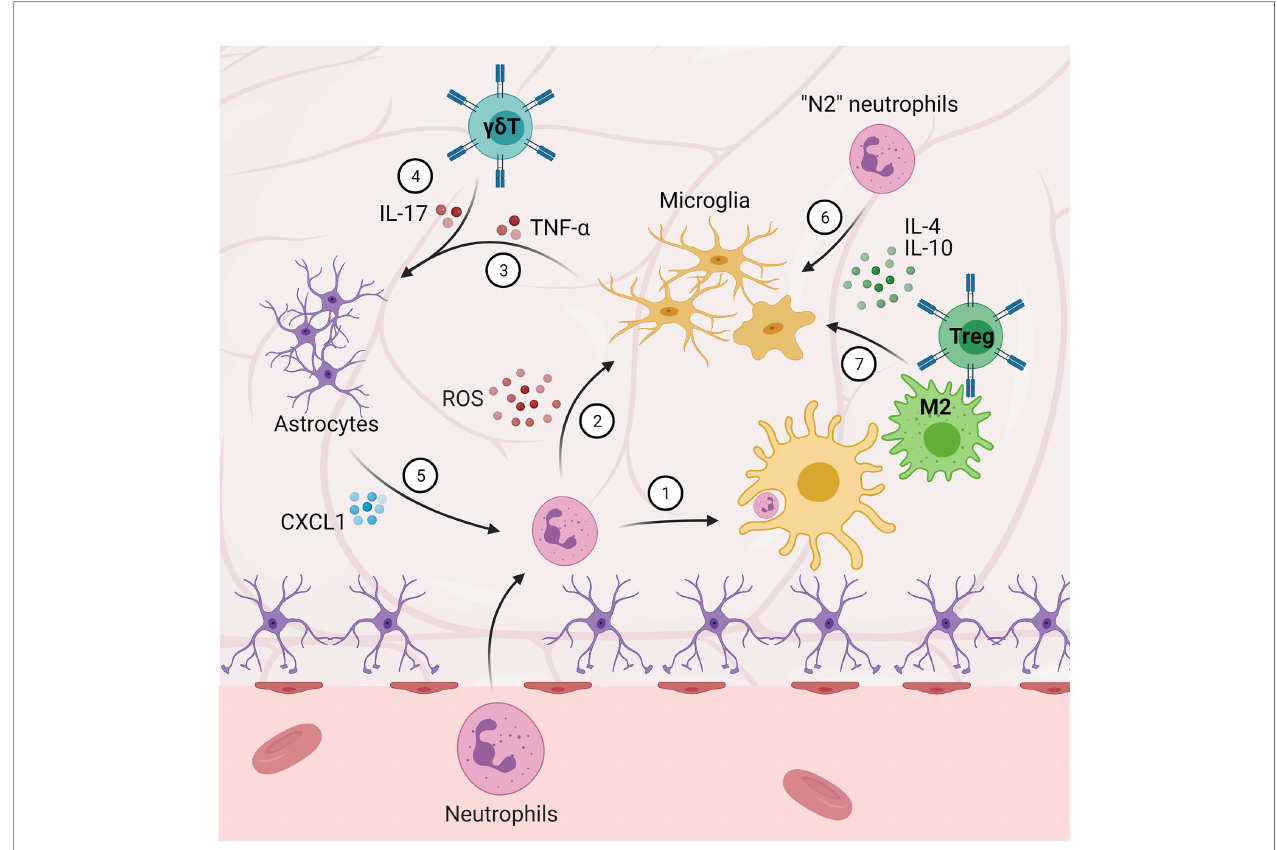
FIGURE 2 | Central-peripheral immune crosstalk in stroke and traumatic brain injury. (1) Microglia phagocytize in fi ltrating neutrophils. (2) Neutrophils that are not phagocytized secrete ROS and proteinases, amplifying M1 microglial activation. (3-5) Microglia-secreted TNF- a and gd T cell-secreted IL-17 induce astrocytic expression of CXCL1, which further contributes to neutrophil-induced pathology. (6) “ N2 ” neutrophils, as well as (7) M2 macrophages and Tregs, promote M2 microglial activation and anti-in fl